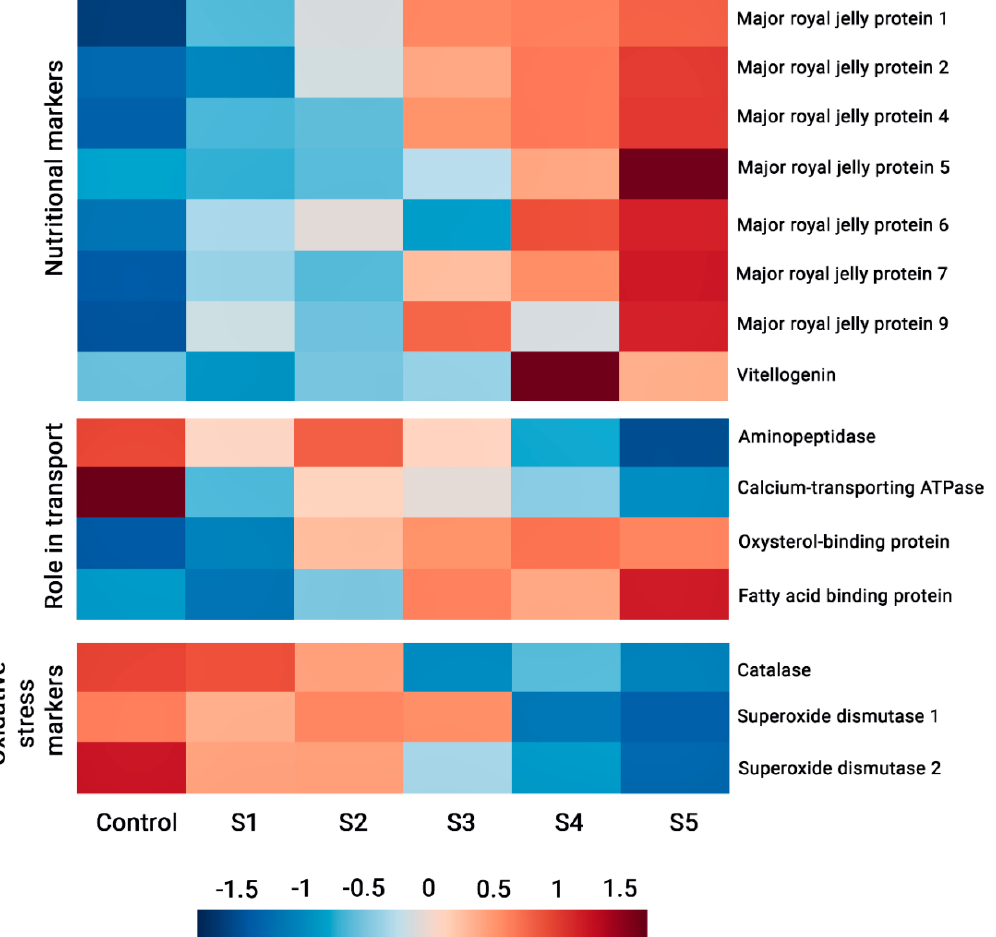
Figure 3. Heat maps plotting the relative abundances of ( A ) all detected 1715 proteins and ( B ) 1089 identified proteins across the treatment groups. C indicates control. S1–S5 indicate dietary groups treated with 0.1%, 0.25%, 0.5%, 0.75% and 1.0% dry diet weight of 24-methylenecholesterol respectively. Numbers 1–3 for every group indicate the replicate cage number.